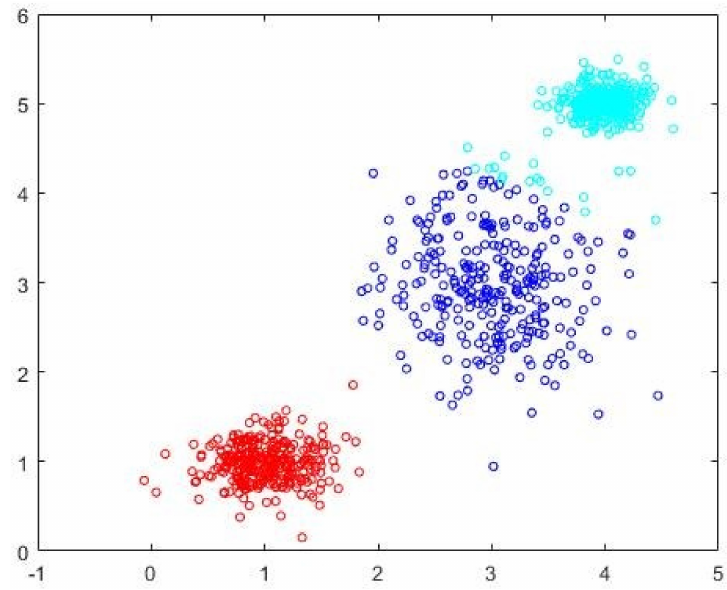
Figure 3. FCM-AO with randomly initialized cluster prototypes for c = 3.